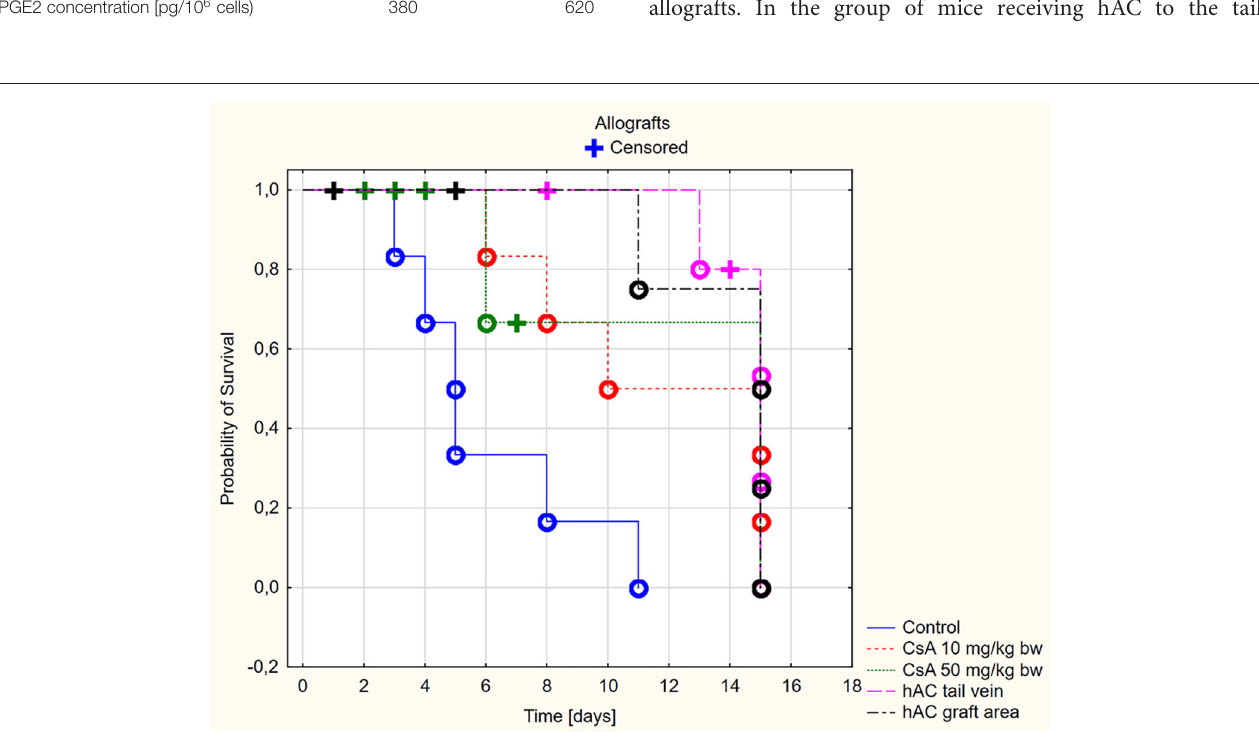
FIGURE 2 | Skin allografts survival time. Censored ( + )—individuals that left the study before the day of massive graft rejection or on 15th day of breeding, due to severe side effects; Completed (o)—individuals observed until 15th day of breeding or until the graft massive rejection has occurred (80% of the graft surface necrosis).